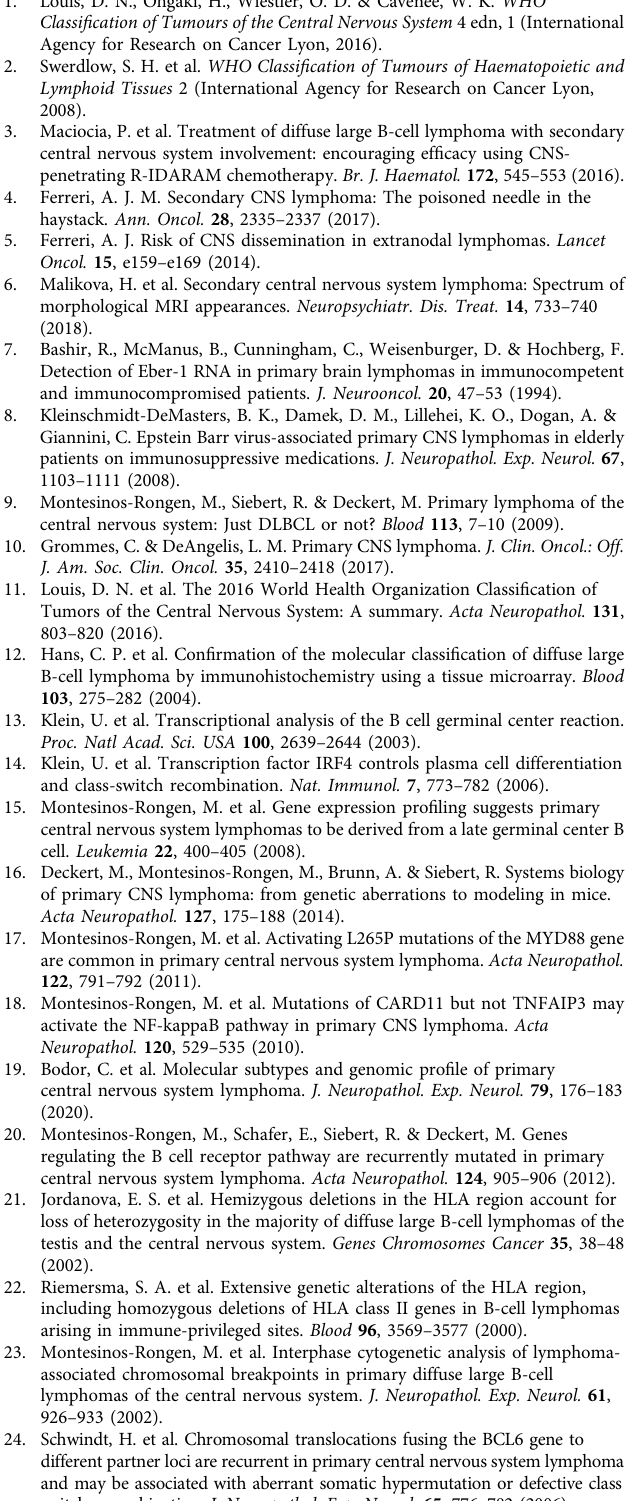
FFPE tissue sections. The following primary antibodies were used: monoclonal mouse anti-BCL6 (DAKO, M7211, 1:10), monoclonal mouse anti-CD10 (Novocastra, NCL-CD10-270, 1:10), monoclonal mouse anti-CD20 (DAKO, M0755, 1:400), polyclonal rabbit anti-CD3 (DAKO, A0452, 1:100),